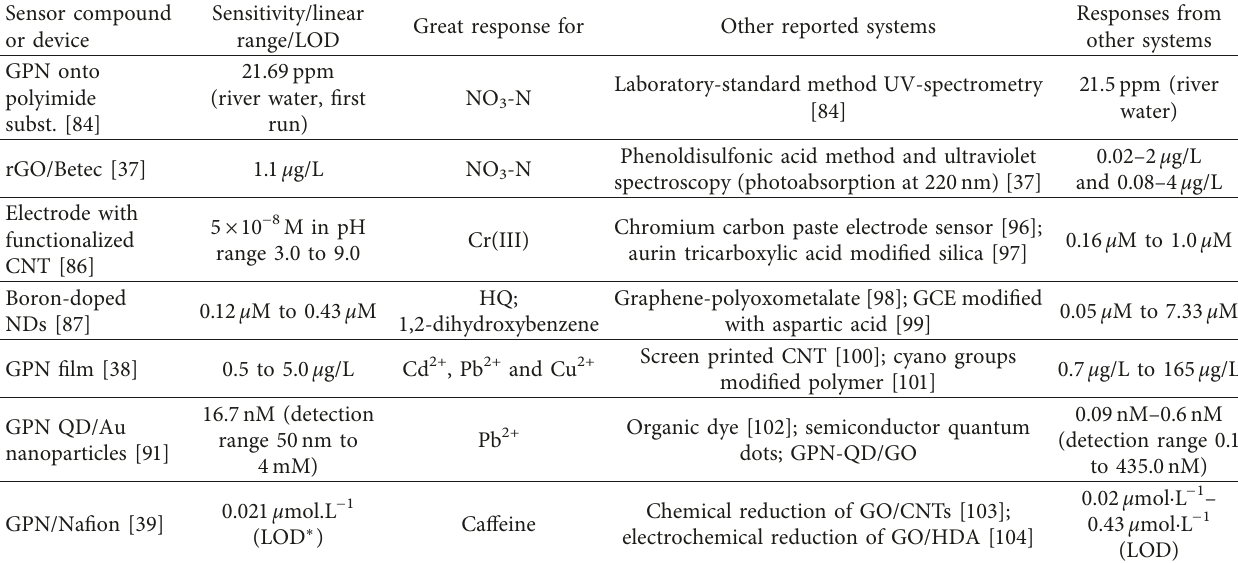
Table 2: Comparison between some of the molecules and chemical elements sensor systems described in this review and different systems found in the